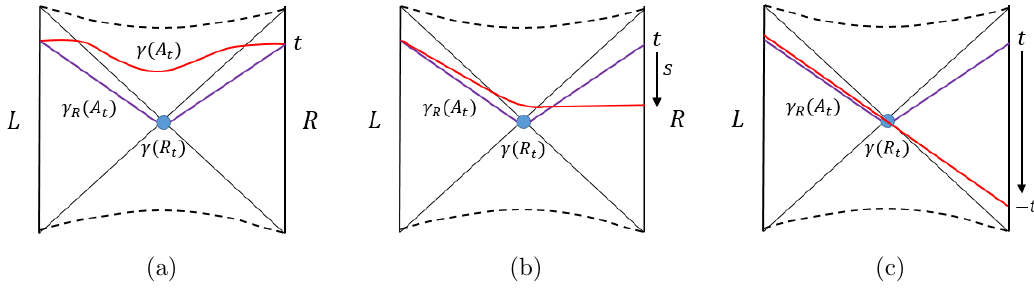
Figure 4. (a) We consider the situation of the j TFD ( t ) i state, where (cid:13) ( A t ) ; (cid:13) ( R t ) are not in the same Cauchy slice. The constrained surface (cid:13) R ( A t ) crosses the bifurcation surface. (b) Modular evolution shifts the endpoint of the HRT surface (cid:13) ( A t ). The entanglement entropy S ( A ) after the modular evolution can be calculated through the length of the shifted HRT surface. (c) The shifted HRT surface reaches minimal length when it goes through the bifurcation horizon (cid:13) ( R t ). By symmetry, the area of this surface is the same as that of (cid:13) R ( A t